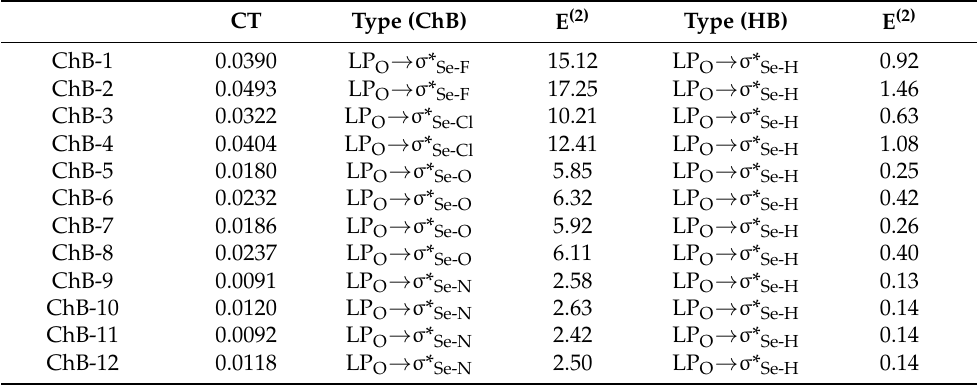
Table 3. Charge transfer (CT, e) and second-order perturbation energies (E (2) , kcal/mol) in the chalcogen-bonded dyads.